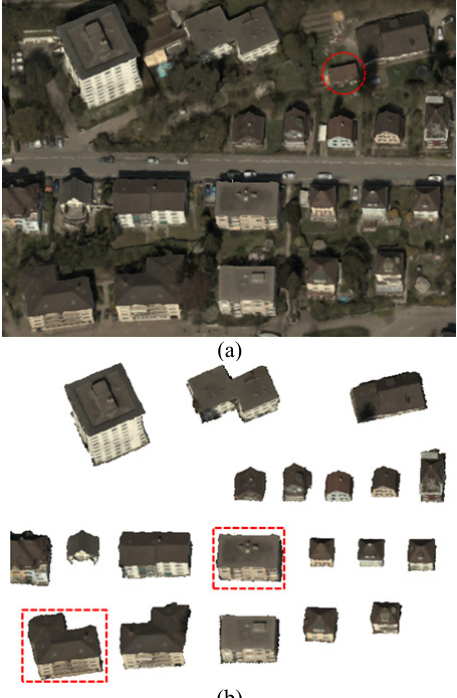
Fig.9. (a) 3D textured mesh of test area. (b) building meshes extracted by contour based